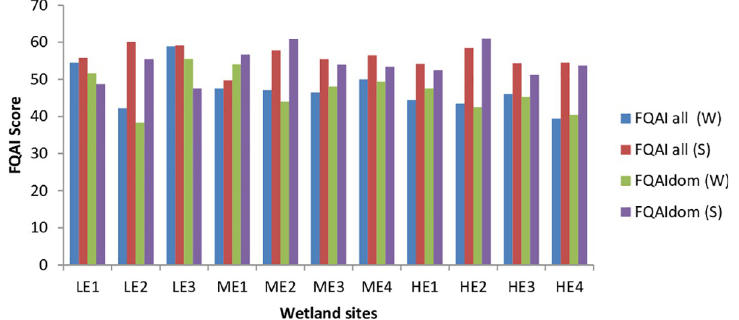
Fig 3. Floristic Quality Assessment Index (FQAI recorded in each of the selected wetlands in two seasons. (LE 1–3 = Less Eroded, ME1–4 = Moderately Eroded, HE1–4 = Highly Eroded).